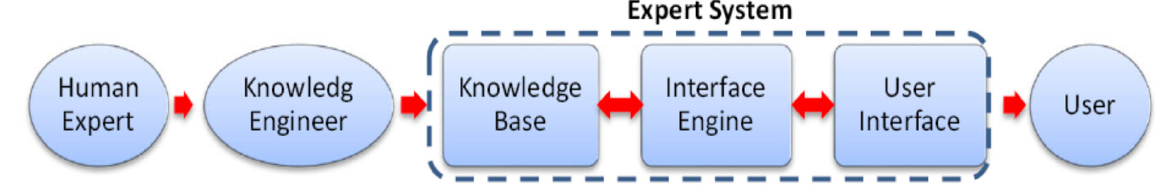
Figure 3. Components of the expert system.